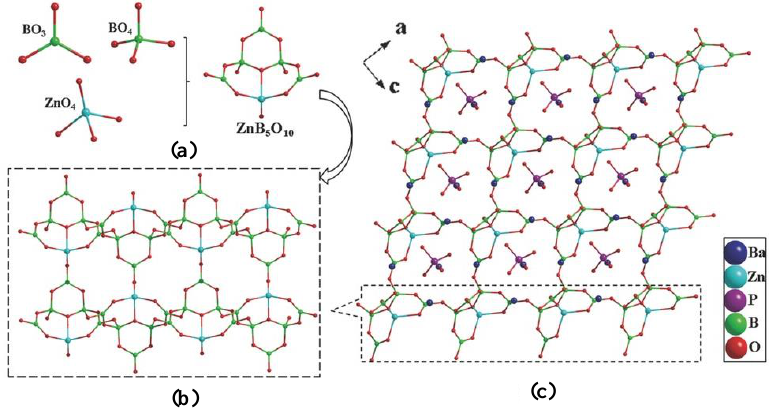
Figure 13. The crystal structure of Ba 3 (ZnB 5 O 10 )PO 4 . ( a ) The [ZnB 5 O 10 ] 3 − units consist of [BO 3 ] 3 − , [BO 4 ] 5 − , and [ZnO 4 ] 6 − polyhedra; ( b ) The 3 ∞ [ZnB 5 O 10 ] network within which the ( c ) [PO 4 ] 3 − anions and Ba 2+ cations occupy the channels. Reprinted from Ref. [60], with permission of John Wiley and Sons.